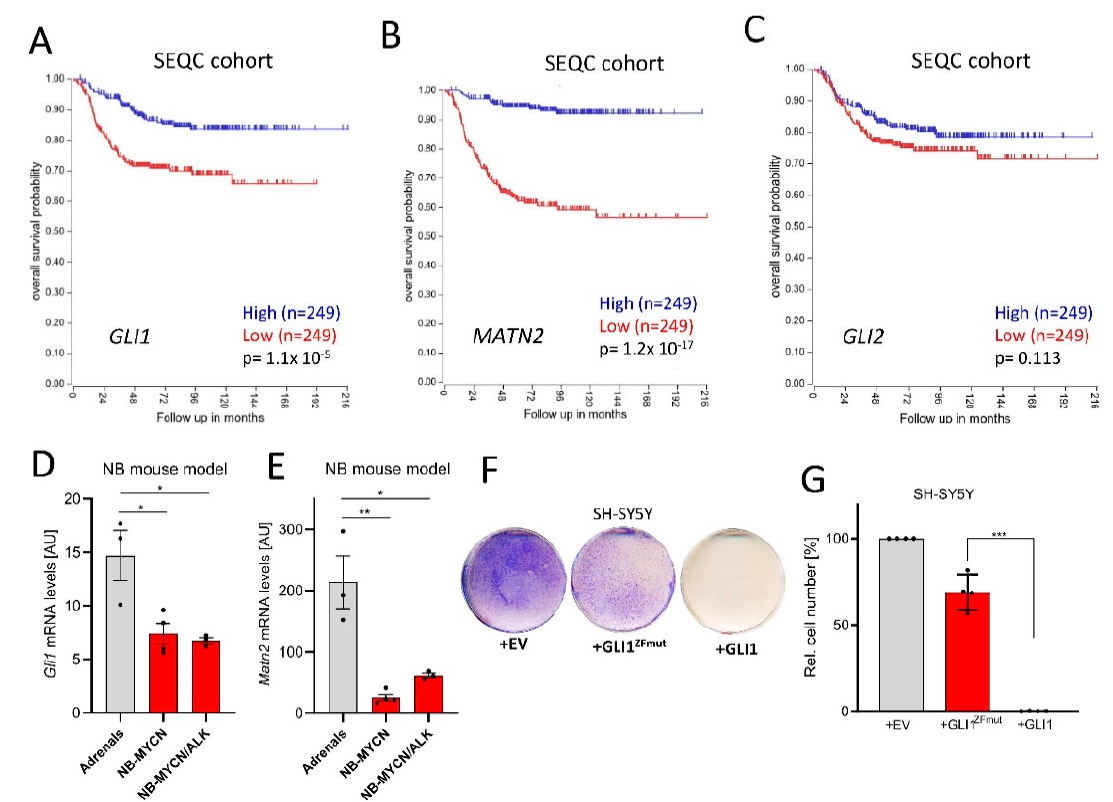
Figure 1. GLI1 exerts tumor-suppressive roles in neuroblastoma (NB). ( A ) Kaplan–Meier curves depicting overall survival of NB patients in relationship to the GLI1 expression (SEQC cohort, median split, logrank test). ( B ) Kaplan–Meier curves depicting overall survival of NB patients in relationship to the MATN2 expression (SEQC cohort, median split, logrank test). ( C ) Kaplan–Meier curves depicting overall survival of NB patients in relationship to the GLI2 expression (SEQC cohort, median split, logrank test). ( D ) Gli1 mRNA expression in normal mouse adrenals, Mycn -induced murine NB or Mycn/ALK -induced murine NB (Heukamp et al., 2012). Shown is the mean ± SD of 3–4 animals. ( E ) Matn2 mRNA expression in normal mouse adrenals, Mycn -induced murine NB or Mycn/ALK -induced murine NB (Heukamp et al., 2012). Shown is the mean ± SD of 3–4 animals. ( F ) Colony stain (blue) of SH-SY5Y cells transfected with empty control vector (EV), GLI1 ZFmut (DNA binding-deficient) or wildtype GLI1 . One representative experiment of n = 4 is depicted. ( G ) Quantification of the experiment shown in ( F ). Mean of n = 4 ± SD. Significances were indicated as * p < 0.05, ** p < 0.01, *** p < 0.001.